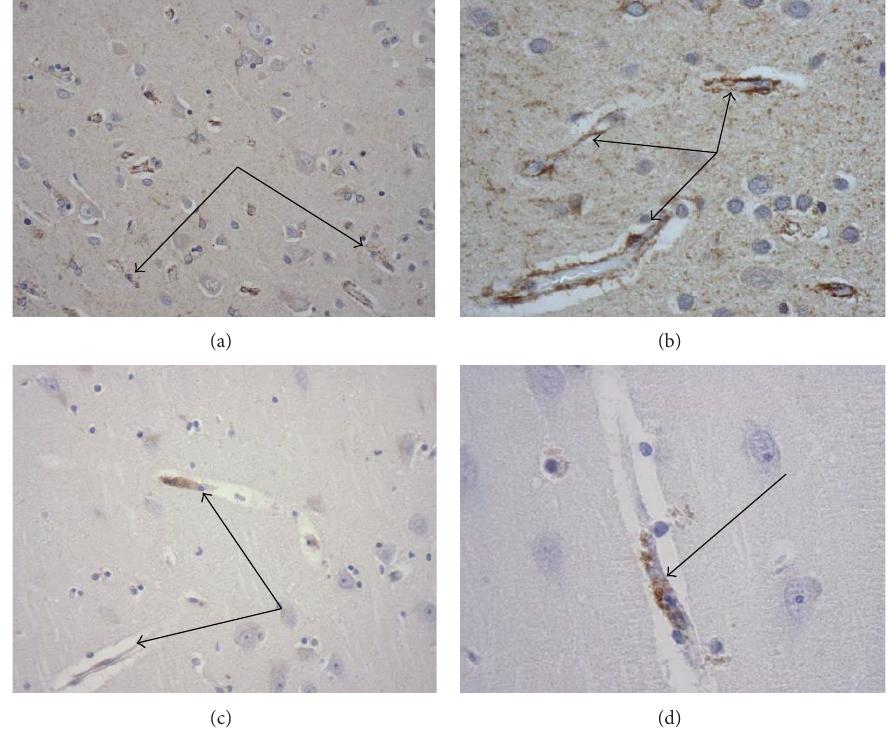
Figure 3: Immunohistochemical illustrations (arrows) of blood-brain barrier endothelial cell associated and vasoactive proteins. Immunohistochemical staining for (a and b) VEGF, × 200 & × 400, respectively; (c and d) eNOS, × 200 & × 400,